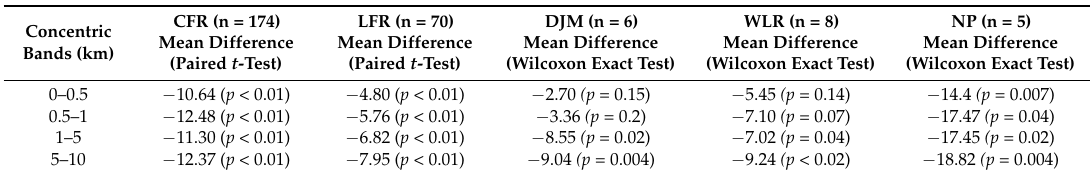
Table 4. Leakage: Mean differences in carbon change (t/ha) and the significance level of the paired-test between external buffer zones and a corresponding internal zones of effective PAs by management categories, ( p < 0.01) highly significant. For the categories DJM, WLR and NP, p values are results of Wilcoxon paired test.